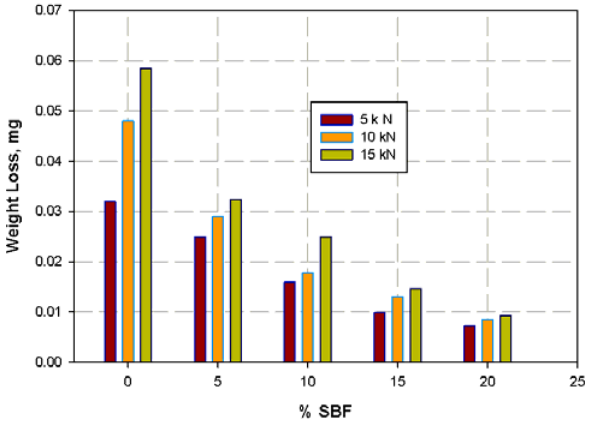
Figure 12. Wear resistance variation with wt % of SBF.